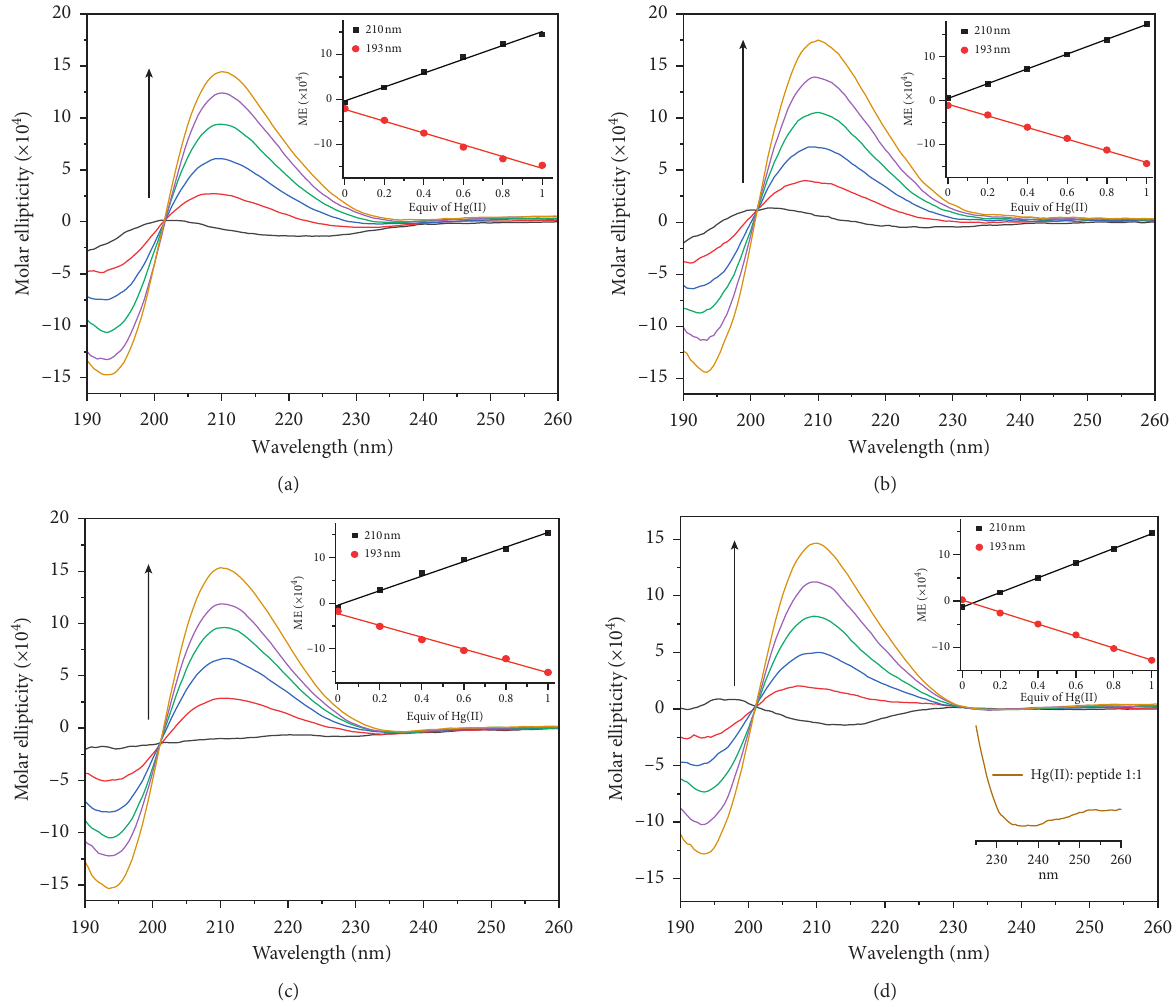
Figure 4: Circular dichroism spectra of 100 μ M tetrapeptides, (a) CGCG , (b) ECGC , (c) HCGC , and (d) WCGC following titrations with increasing mole equiv of HgCl 2 as indicated by direction of arrow for 210 nm band. Insets show changes in molar ellipticity value at 193nm and 210nm versus mole equiv of HgCl 2